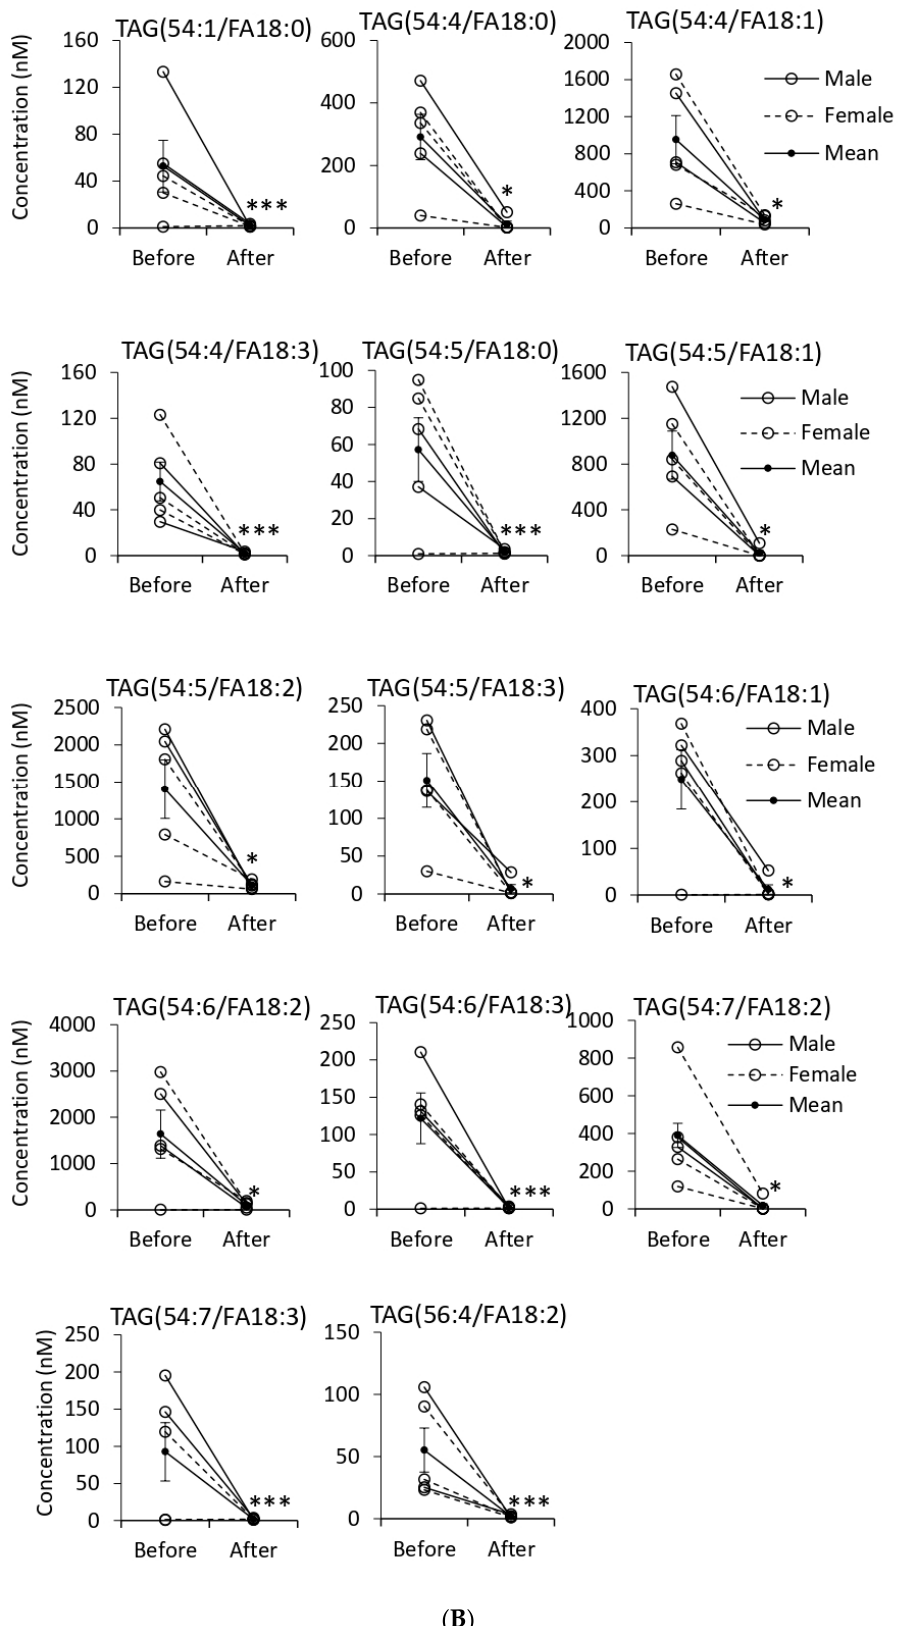
Figure 4. Shortlist of the exosomal lipids affected by Tempol infusion. Urinary EVs lipids were quantified based on the concentration of the surrogate internal standards. Sphingolipids and glycerophospholipids ( A ) and glycerolipids ( B ) with an increase in the concentration or >10X decrease in the concentration after Tempol treatment were presented. A paired t-